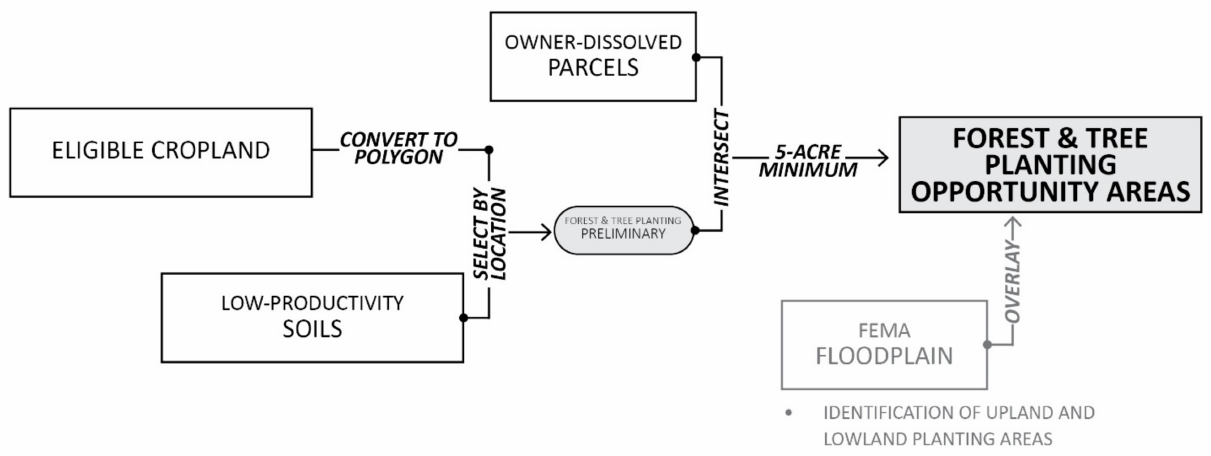
Figure 6. Diagram illustrating the general method of geospatial analysis for identifying forest and tree planting